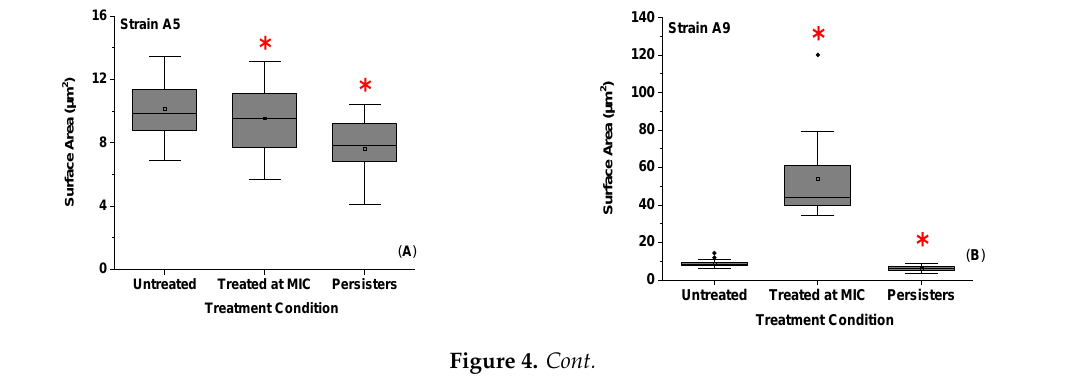
Figure 3. Representative SEM images of: ( A , D ) MDR E. coli untreated cells of Strains A5 and A9, respectively; ( B , E ) cells of Strains A5 and A9 exposed to ampicillin at MIC for 3 h, respectively; and ( C , F ) persister cells of Strains A5 and A9 exposed to ampicillin at 20× MIC, respectively. Red arrows on images C and F for both Strains show intact cells with expected surface morphologies, while blue arrows on images C and F indicate cells with ampicillin-induced damage, n = 3 independent cultures. Note the elongation of A9 cells when treated at MIC (image E ).